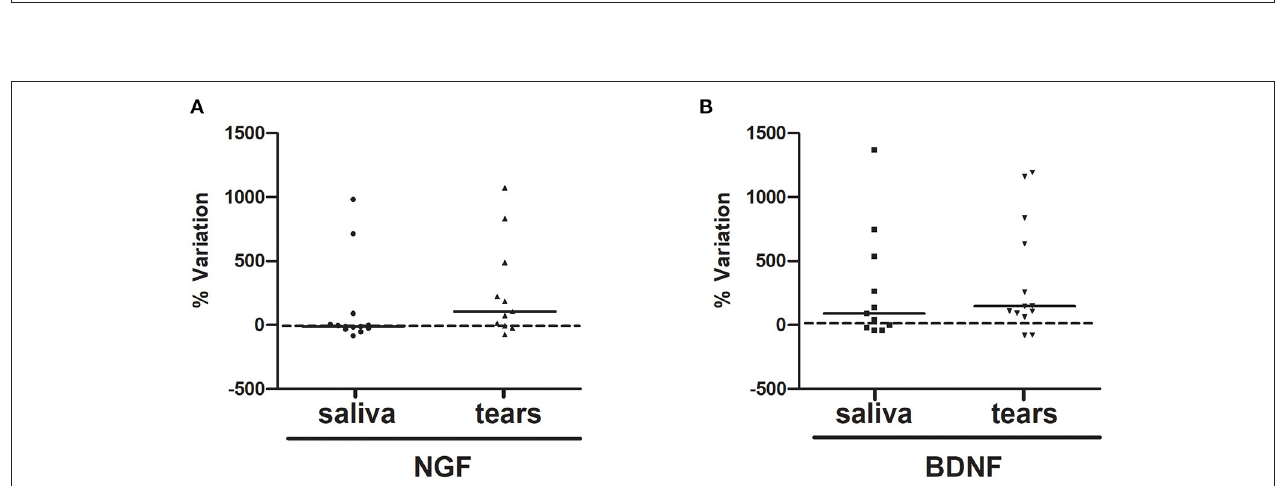
FIGURE 4 | (A,B) . NGF and BDNF %variations upon RR training in the last session. The variations between pre and post values percentualized on pre value (post-pre)/pre*100 of NGF ( A , saliva and tears) and BDNF ( B , saliva and tears) were displayed by scatter plot.